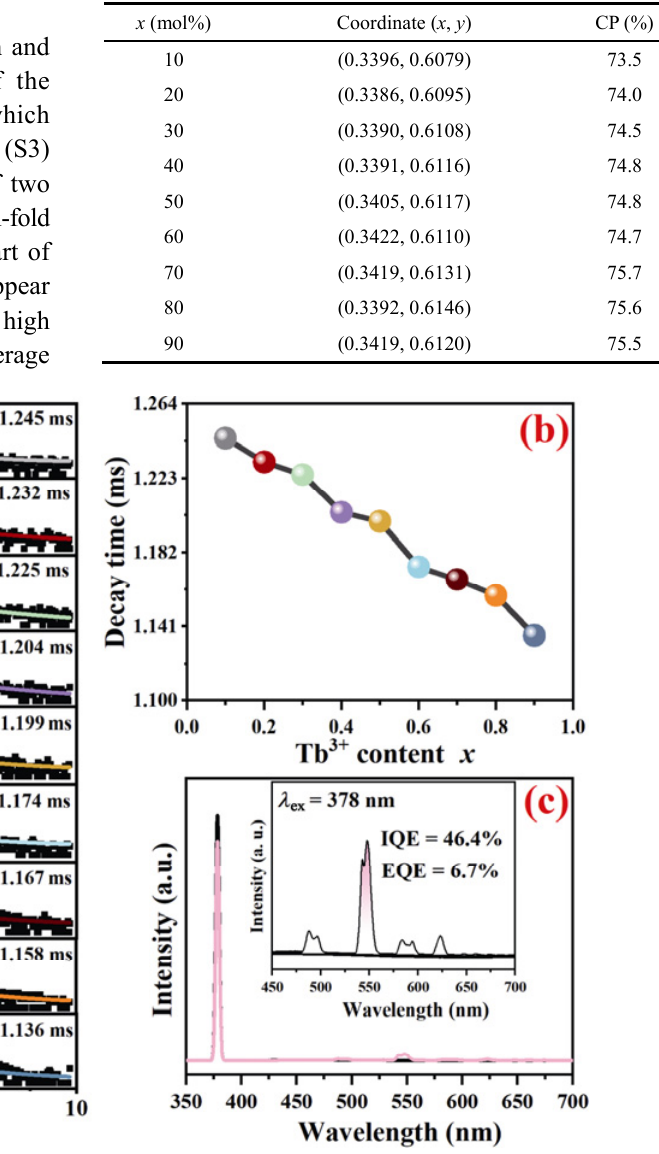
Fig. 6 (a) Decay curves of NYTB: x Tb 3+ ( x = 10 ‒ 90 mol%). (b) Decay time in response to Tb 3+ content. (c) IQE and EQE of NYTB:70%Tb 3+